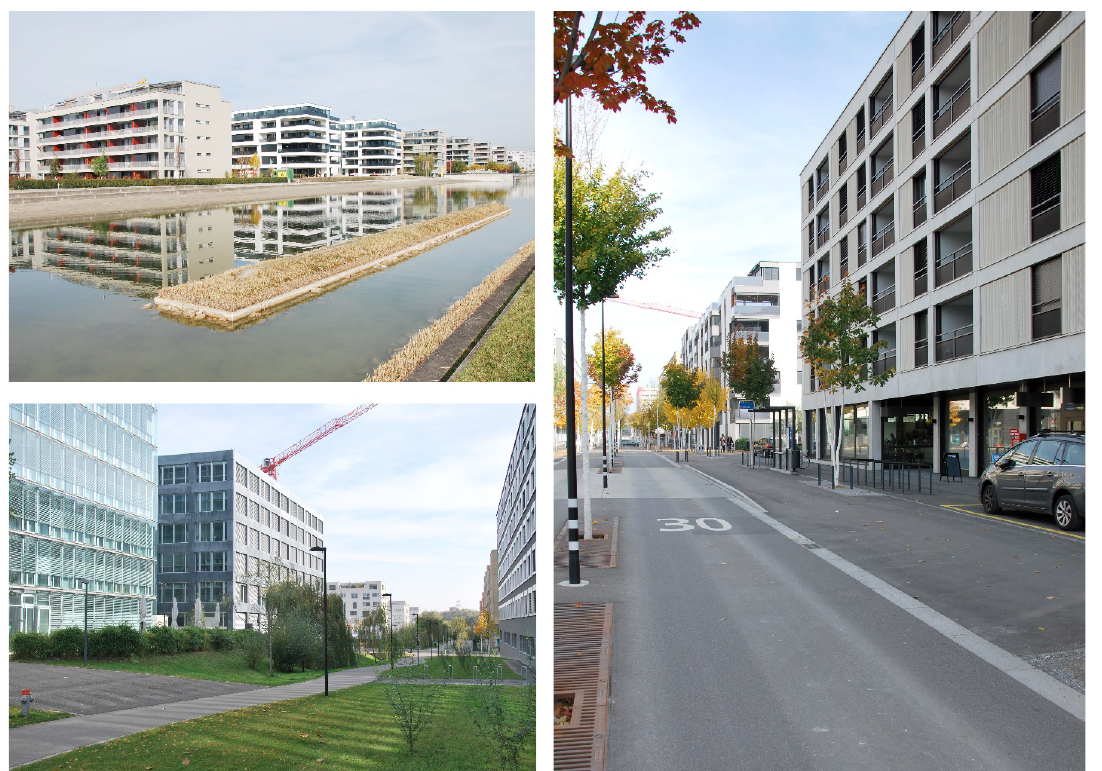
Figure 9. The three defined zones show the building design and design of public spaces in the case study of Glattpark. Source: